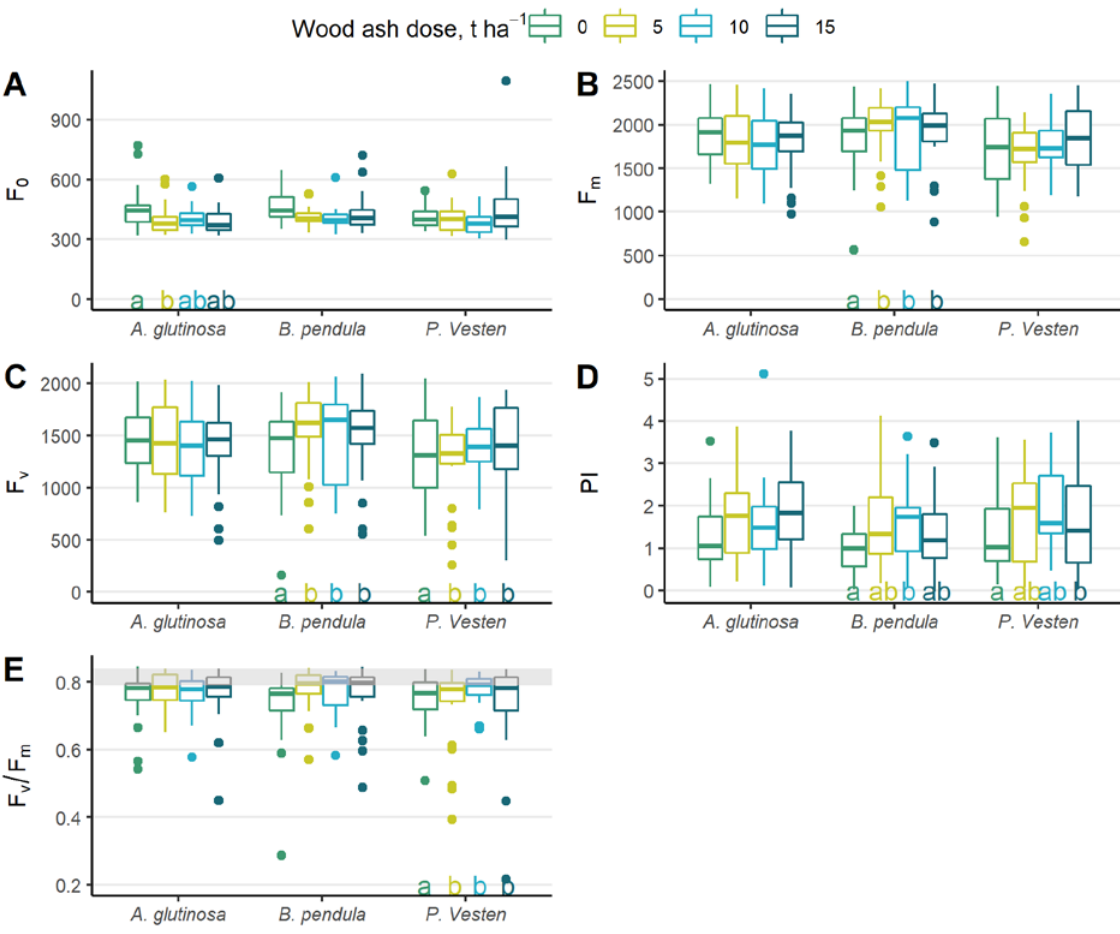
Figure 5. Studied tree species traits. (A) initial fluorescence, F 0 (B) maximal fluorescence, F m (C) variable fluorescence, F v (D) Performance index (PI) (E) F v and F m ratio (optimal region for this parameter is coloured in grey). Letters denote significant (p adj . < 0.05) differences between fertiliser dose for each species.